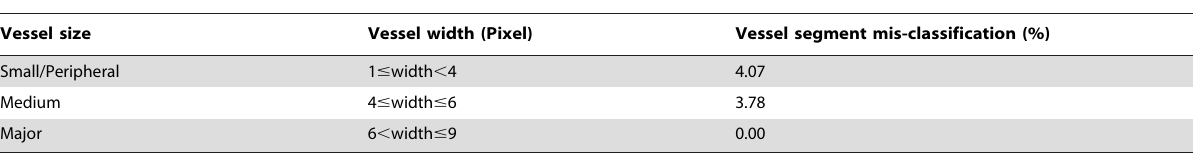
Table 2. Proportion of mis-classified vessel segments.